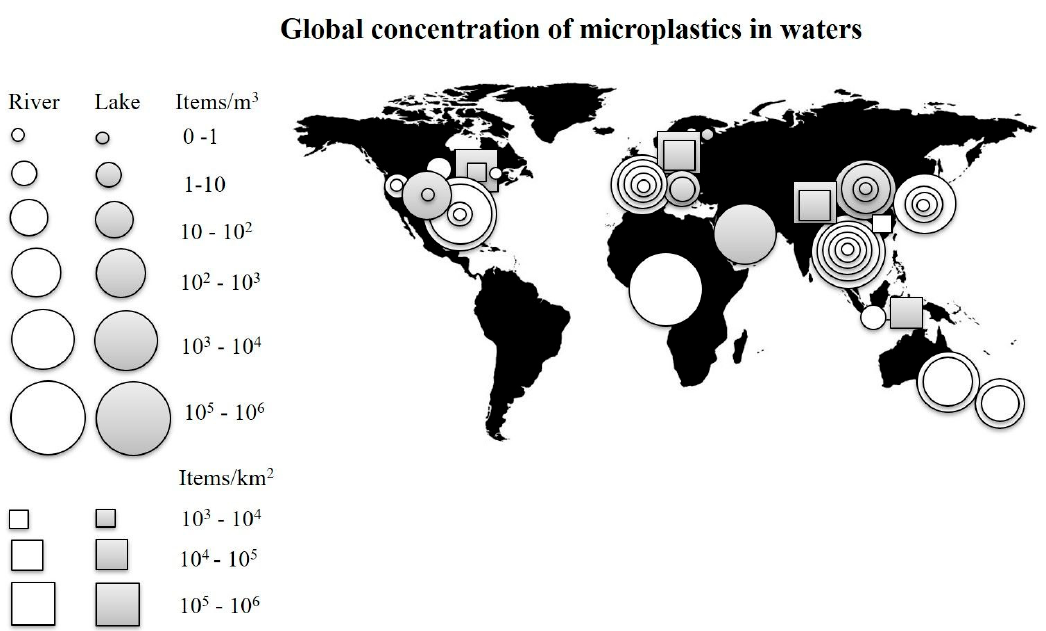
Figure 5. Global concentration of microplastics in lotic and lentic waters expressed in items/m 3 and items/km 2 : Stacked concentric circles and rectangles indicate the presence of multiple different concentration values in the same study area.